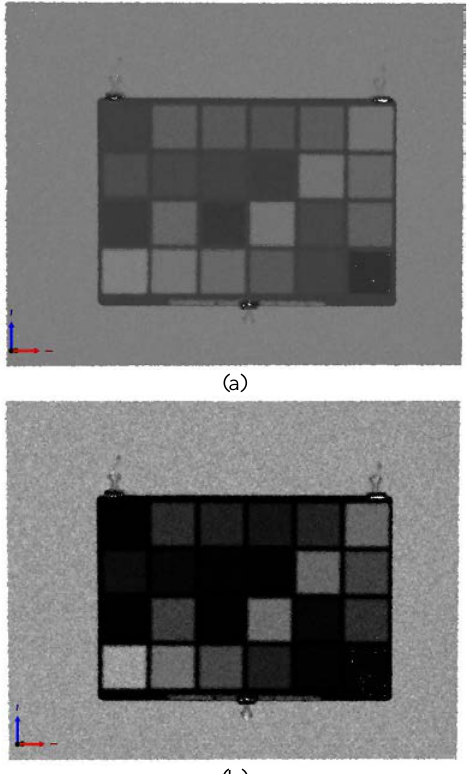
Figure 7. ColorChecker Chart: a) Initial intensity values of the point cloud; b) final corrected intensity values after